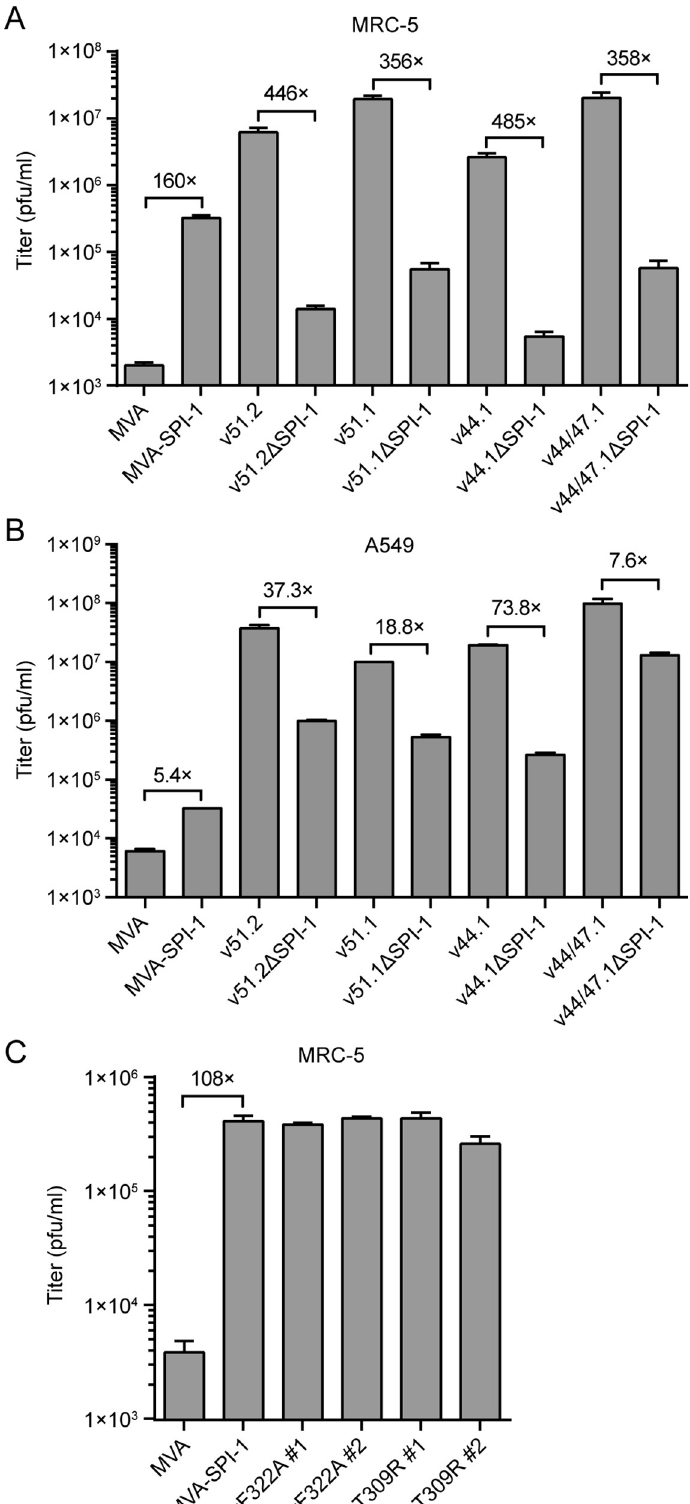
Fig 4. Effect of SPI-1 insertions and deletions on yields of recombinant MVAs. MRC-5 (A) or A549 ( B) cells were infected in triplicate with indicated viruses at a MOI of 0.001 (MRC-5) or 0.01 (A549) cells for 48 h. Virus titers